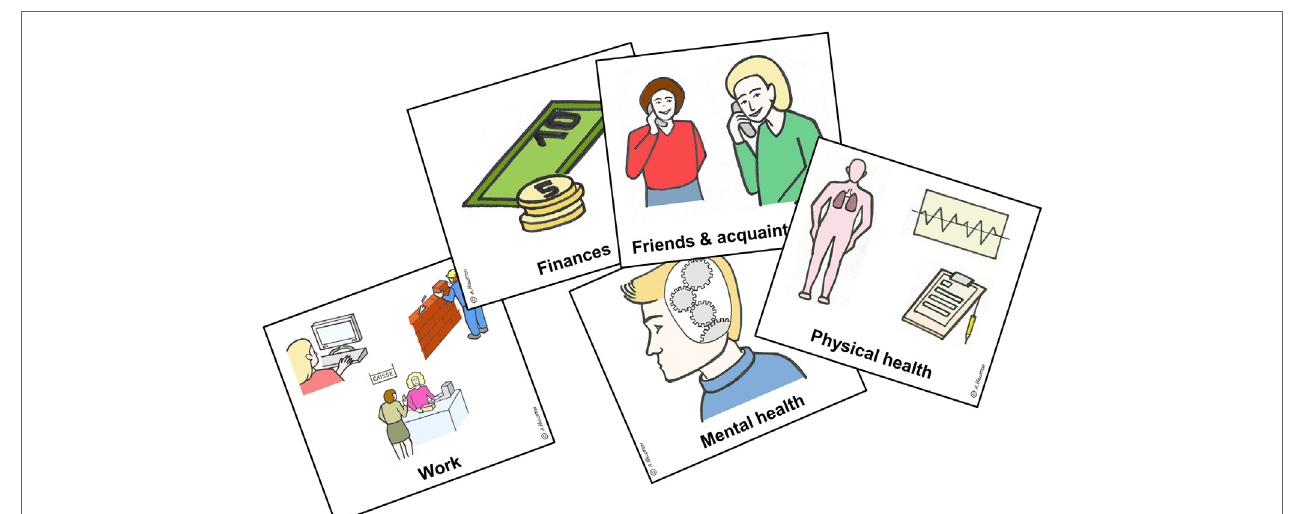
FigUre 1 | example of the Q-sort cards used in the elaDeB